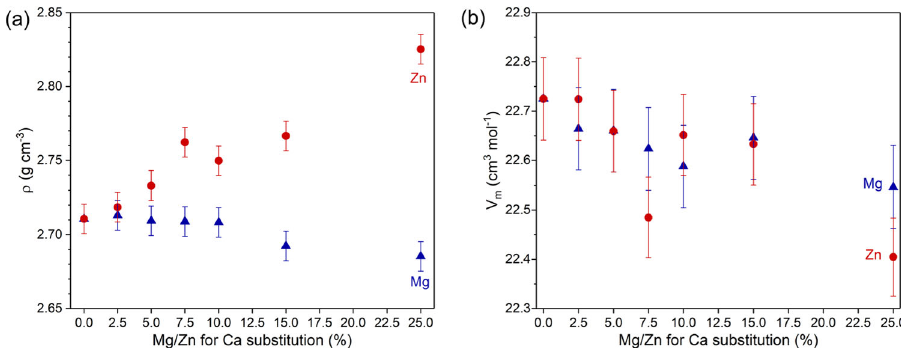
Fig. 1 a Density and b molar volume for Mg (blue triangles) and Zn-substituted (red